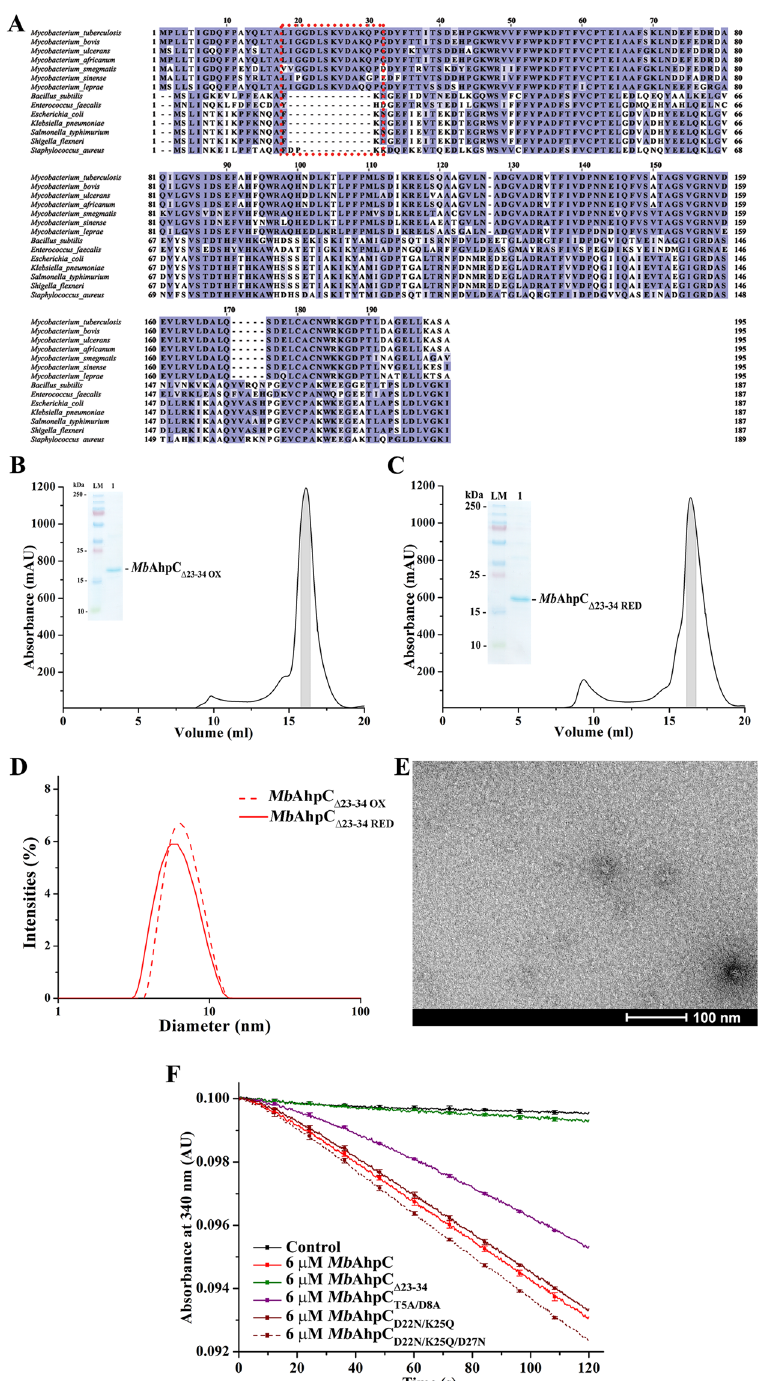
Figure 5. ( A ) Multiple sequence alignments of AhpC from different bacteria using ClustalW 17 . As shown, various Mycobacterium sp . presented extra 15 residues located at the N-terminus ( red dashed box ), which were absent in other bacteria species. Mutations with deletion from residues 23–34 were constructed and both oxidized ( B ) and reduced ( C ) mutants eluted at approximately 16 ml on a Superdex 200 HR 10/30 column and showed high purity on a 17% SDS gel ( inset ). ( D ) DLS analysis of oxidized ( red dashed line ) and reduced ( red solid line ) of Mb AhpC Δ 23–34 . Both redox states of the protein revealed a similar diameter unlike that of wt Mb AhpC. ( E ) Negative stained EM-images of reduced Mb AhpC Δ 23–34 . The lack of ring-shaped particles in the micrograph indicates the inability of Mb AhpC Δ 23–34 to form an oligomeric ring. ( F ) NADPH-oxidation of Mb AhpC, -AhpC Δ 23–34 , -AhpC T5A/D8A , -AhpC D22N/K25Q or -AhpC D22N/K25Q/D27N measured at 50 µ M H 2 O 2 is shown as a representative to highlight the effects of the mutations generated. A control without Mb AhpC is represented with a black solid line . The activity of wt Mb AhpC is indicated with a red solid line . The deletion of residues 23–34 ( green solid line ) altered the activity of the protein, hence, showing activities close to that of